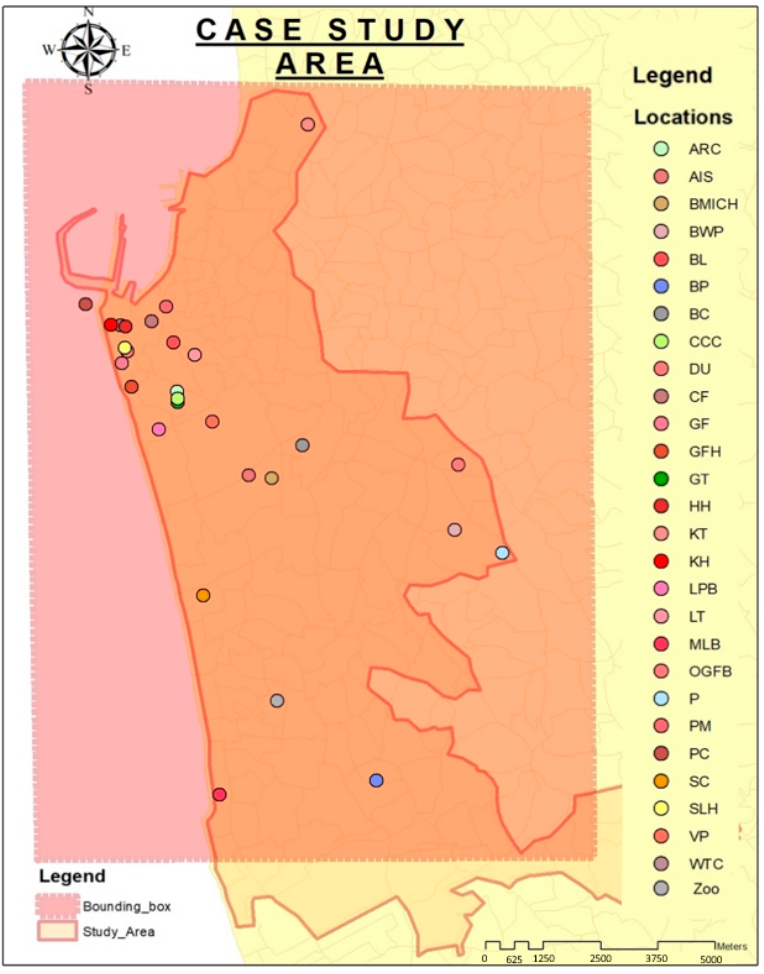
Figure 1. Case study area.